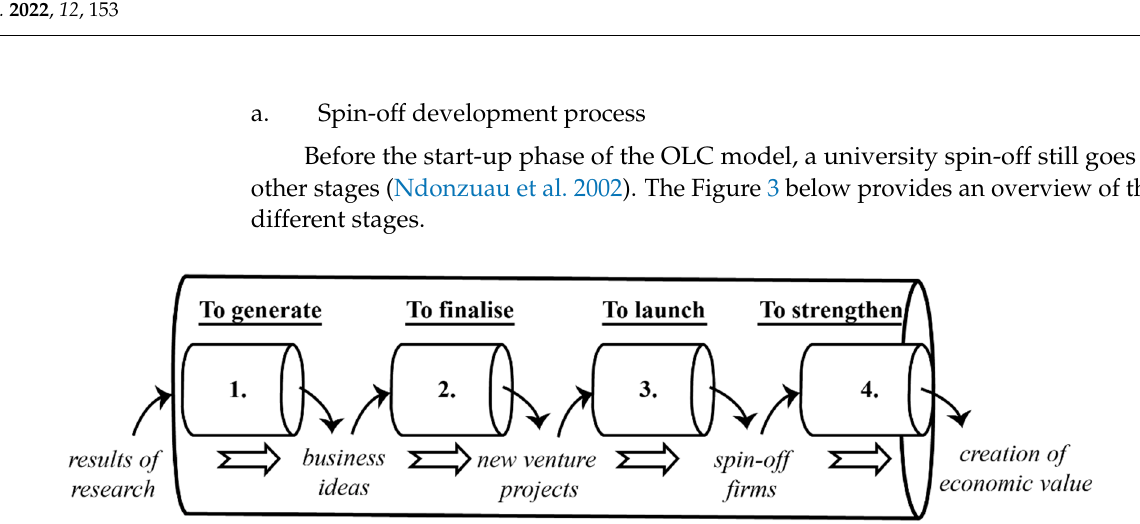
Figure 3. The global process of valorization by spin-off. Adapted from (Ndonzuau et al. 2002).